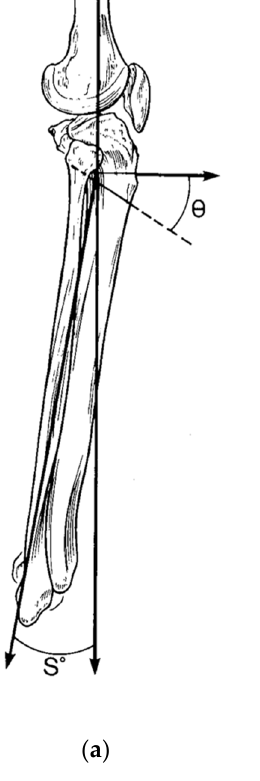
Figure 2. ( a ) Representation of the osteotomy angle theta ( θ ), as illustrated by Sangeorzan et al. [1]. It describes how steep to make the osteotomy based on the sagittal view. It is referenced from a plane transverse to the long axis of the bone at the level of the deformity. θ is always measured distally. If θ is greater than 90°, the osteotomy plane goes from an ascending to a descending cut. ( b ) Corresponding graph that calculates θ based on the true angular deformity (A) and the rotational deformity T [1].